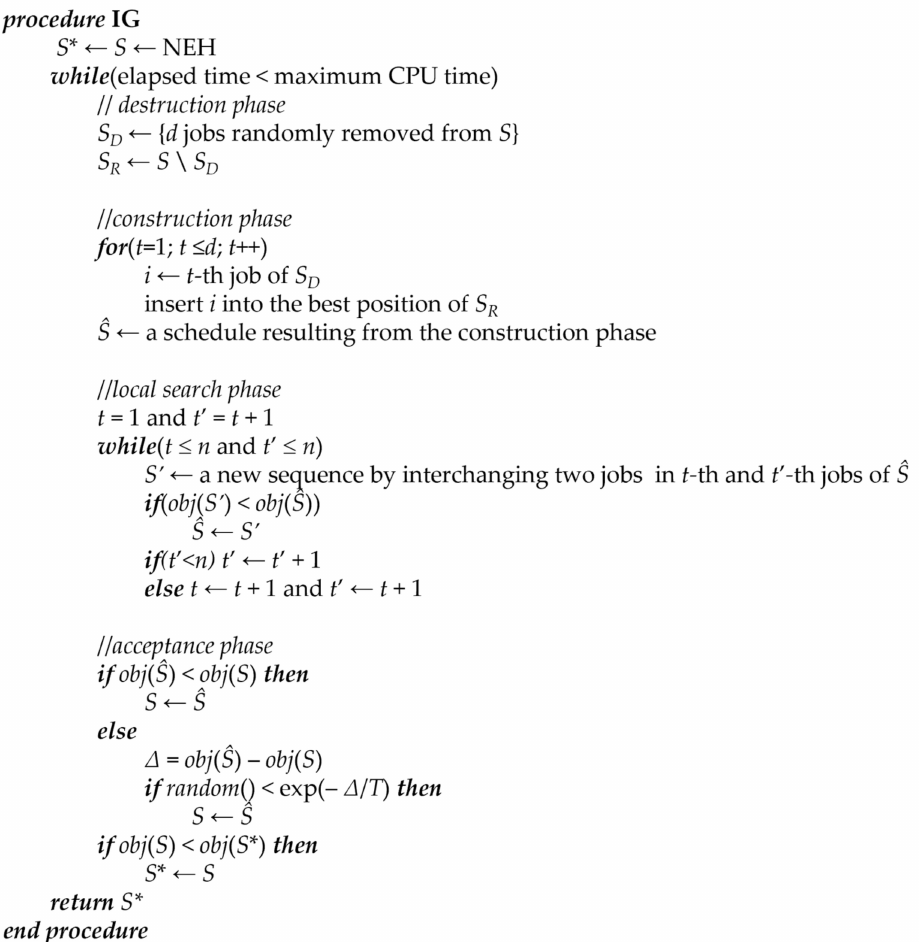
Figure 2. Procedure of the proposed IG